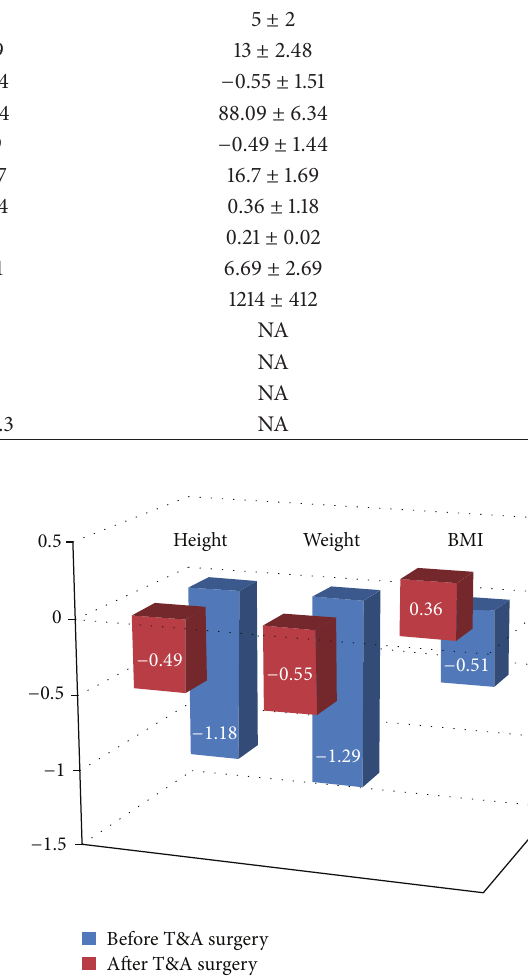
Figure 1: A graphic presentation of the improvement in 𝑍 score for weight, height, and BMI following T&A surgery. It shows the “catch- up” growth that is demonstrated by the gap of standard deviation to the average values of children of the same age ( 𝑍 score = 0) for weight, height, and